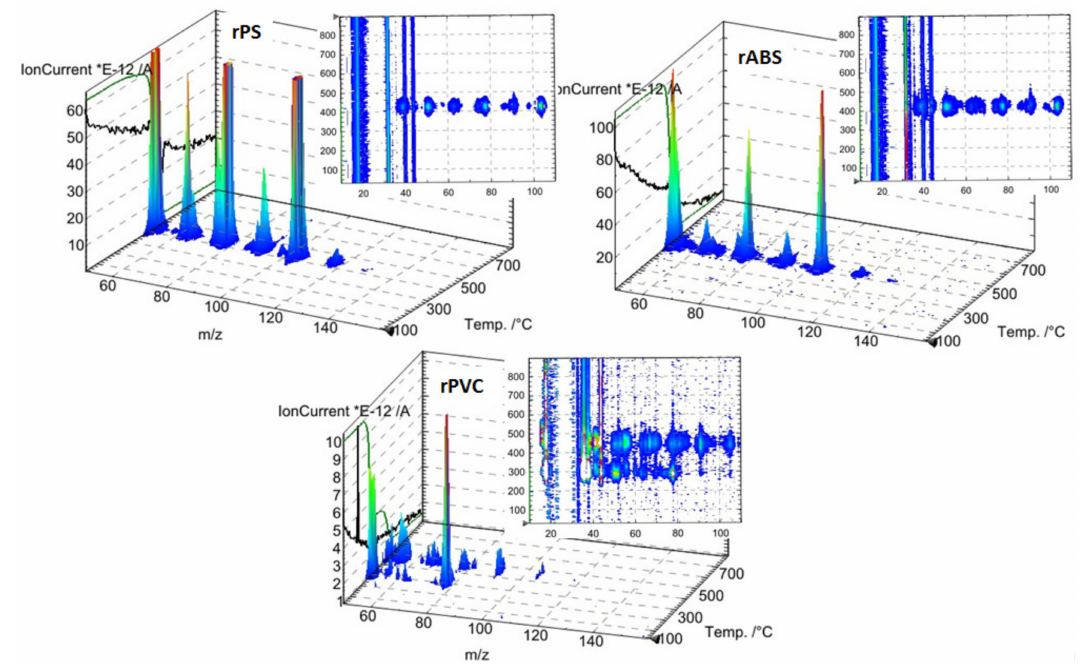
Figure 5. TGA mass spectrophotometer (MS) analysis of rPS, rABS and